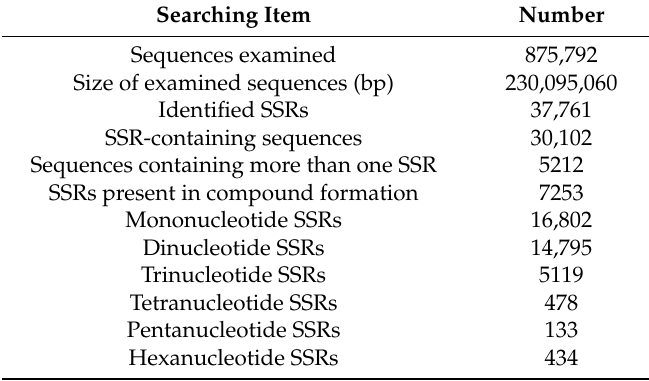
Table 3. Summary of simple sequence repeats (SSRs) identified in T . koraiensis